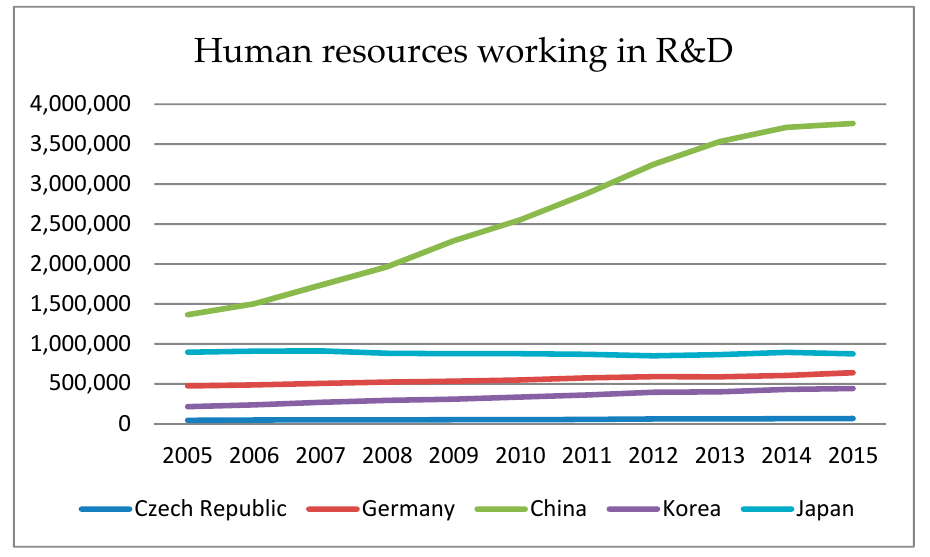
Figure 1. Human resources working in R&D—international comparison for the period 2005–2015 [24].